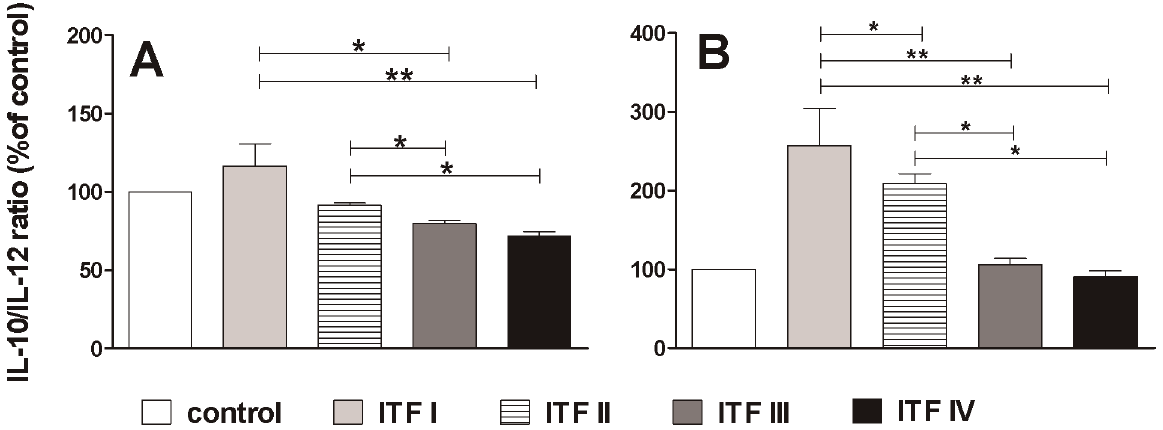
Figure 4. Ratio of IL-10/IL-12 upon incubation of PBMCs with different chain length b 2 R 1-fructans. PBMCs (n=6) were stimulated with 1 m g/ml (panel A) and 100 m g/ml (panel B) b 2 R 1-fructans for 24h. Statistical significance levels were determined with a non-parametric Mann- Whitney U-test for unpaired observations (two-tailed). Mean and SD of the IL-10/IL-12 ratios is plotted for the different b 2 R 1-fructans as percentage of controls, which were set to 100% (n=6) and horizontal bars indicate the significant differences between b 2 R 1-fructan treatments.